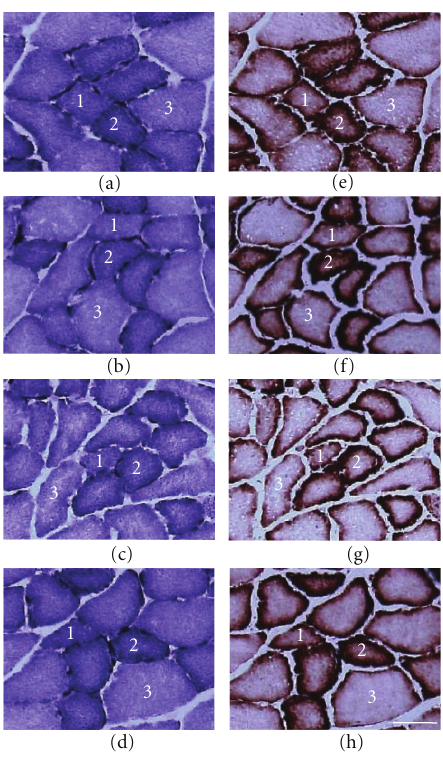
Figure 4: Transverse sections of the extensor digitorum longus muscle assayed for SDH ((a)–(d)) and cytochrome c ((e)–(h)) stain- ing. (a) and (e) LC group; (b) and (f) LH group; (c) and (g) OC group; (d) and (h) OH group. 1: type I fiber; 2: type IIA fiber; 3: type IIB fiber. Bar = 50 μ